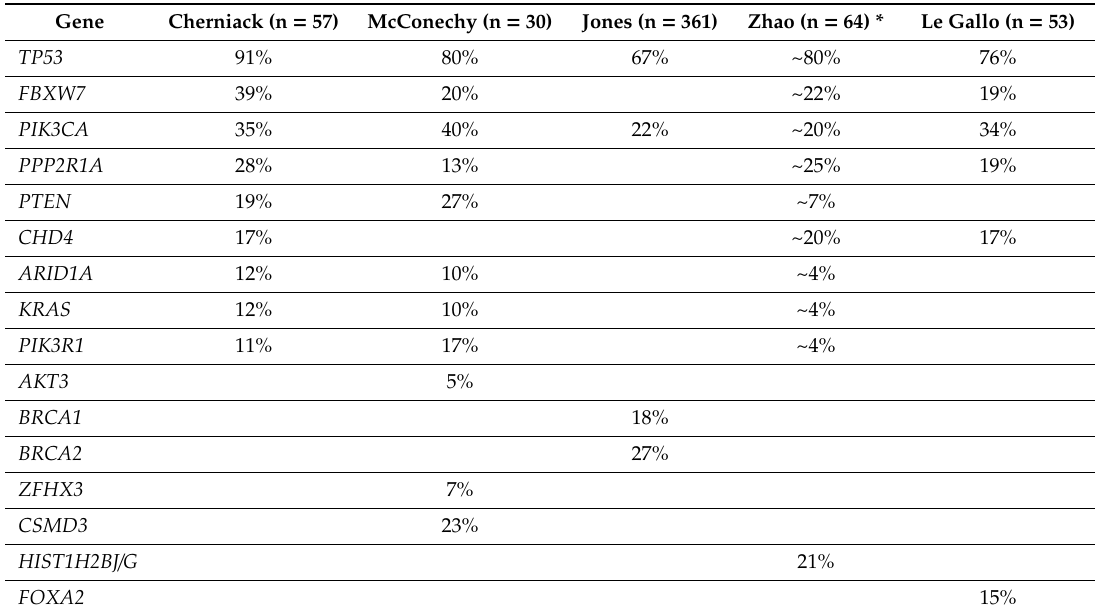
Table 2. Comparison of gene mutation frequency among di ff erent series of Endometrial carcinosarcoma (ECS) analyzed by next-generation